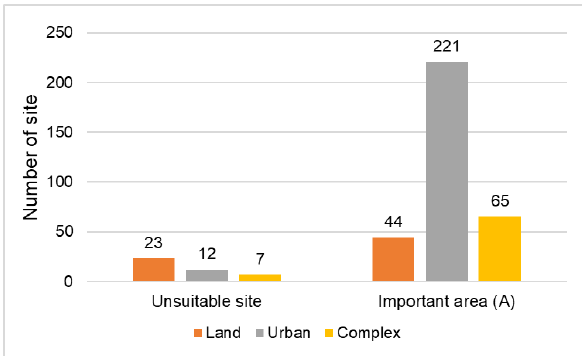
Figure 3. The number of sites assigned to unsuitable and important area (A) classes in the digitized LSM.